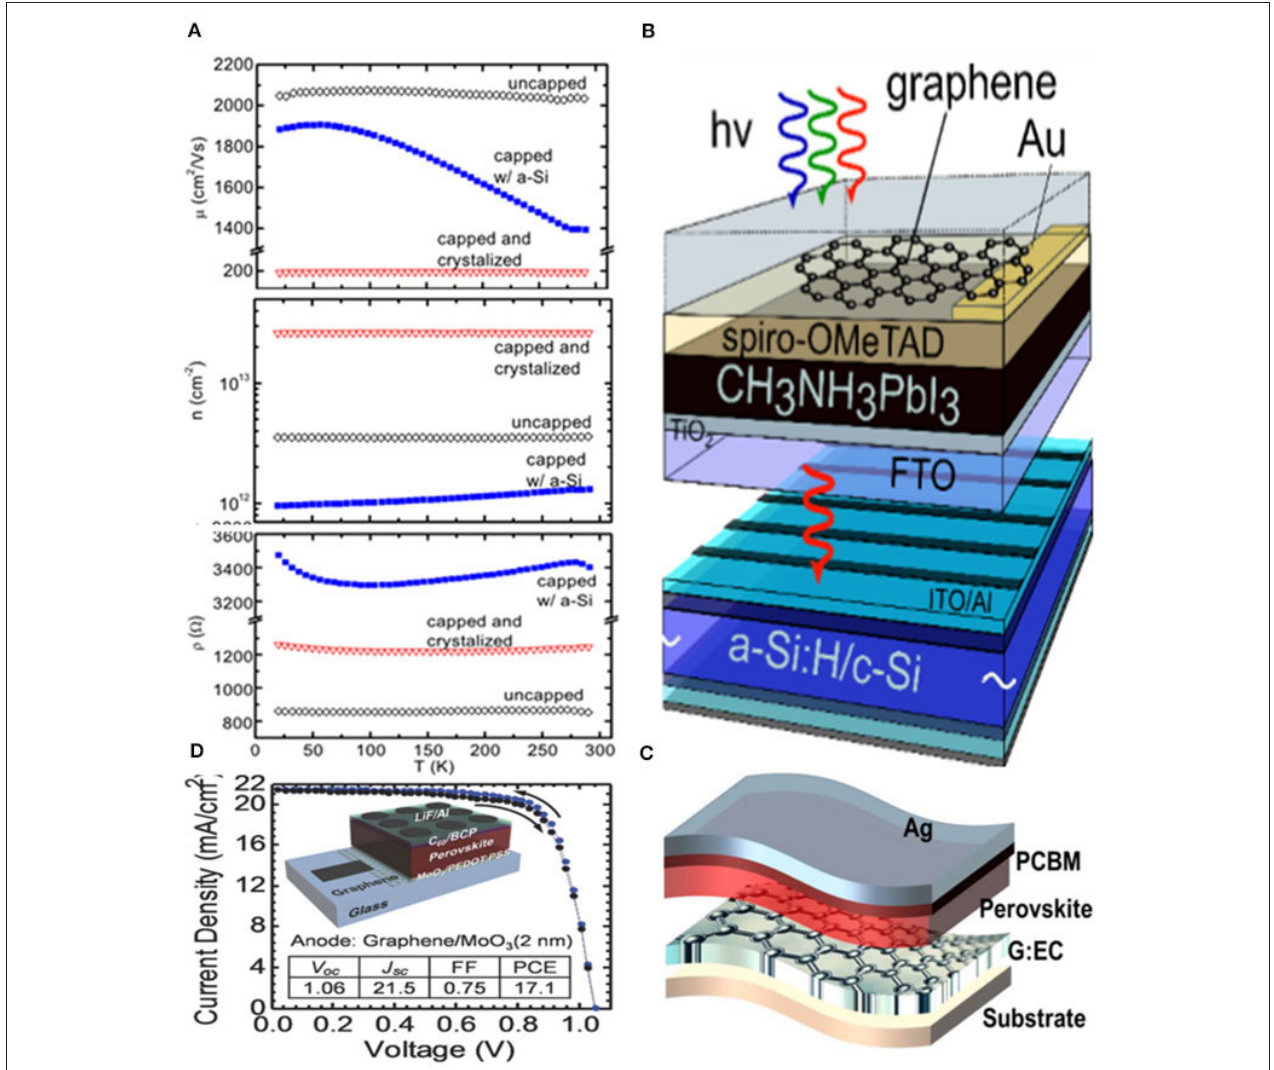
FIGURE 6 | (A) Temperature dependence of Hall mobility, charge carrier density, and sheet resistance of bare graphene on a glass, capped with amorphous, and post-crystallized Si (reproduced from ref. 40, copyright 2013, AIP). (B) Simplified sketch of a four terminal tandem solar cell consisting of graphene based PVSK top solar cell and an amorphous c-Si bottom solar cell (reproduced from ref. 41, copyright 2015, ACS). (C) The device structure of PSCs based on G:EC electrode (reproduced from ref. 42, copyright 2019, Springer). (D) Schematic structure of the inverted MAPbI 3 PVSK solar cells utilizing graphene as a transparent anode (reproduced from ref. 43, copyright 2013, Royal Society of